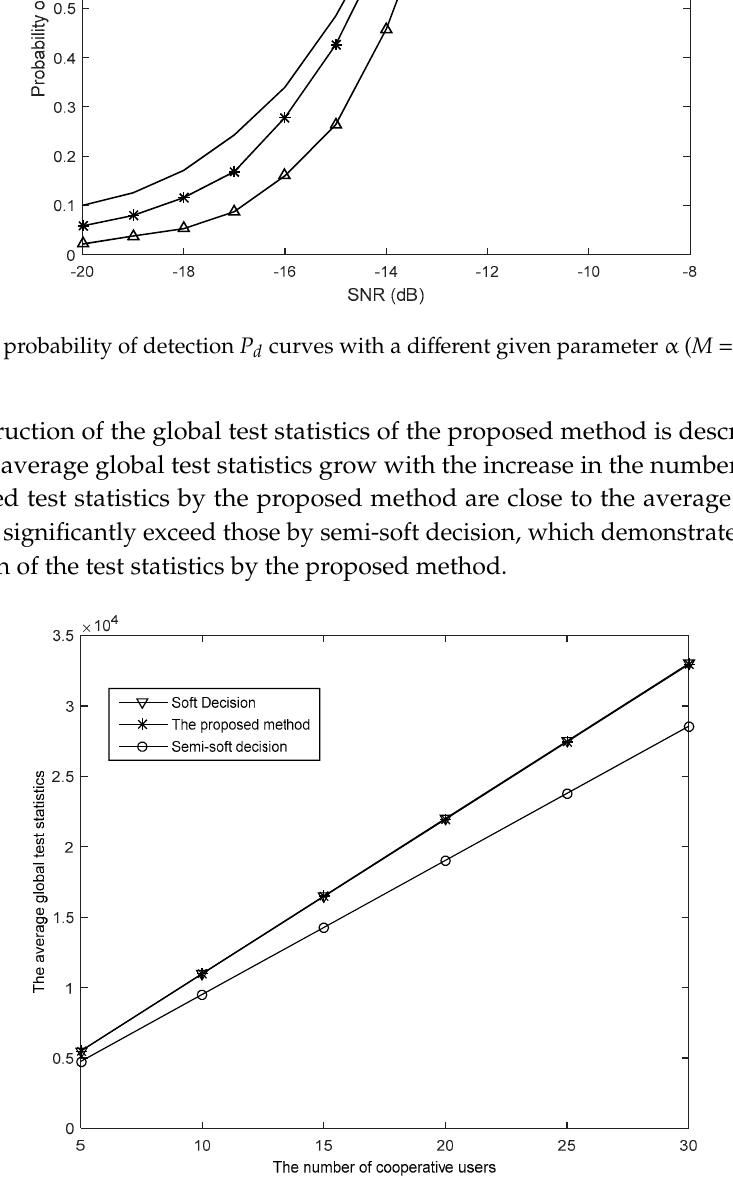
Figure 8. The relationship between the number of SUs and the average global test statistics ( α = 0.05, N = 1000, P f = 0.01).